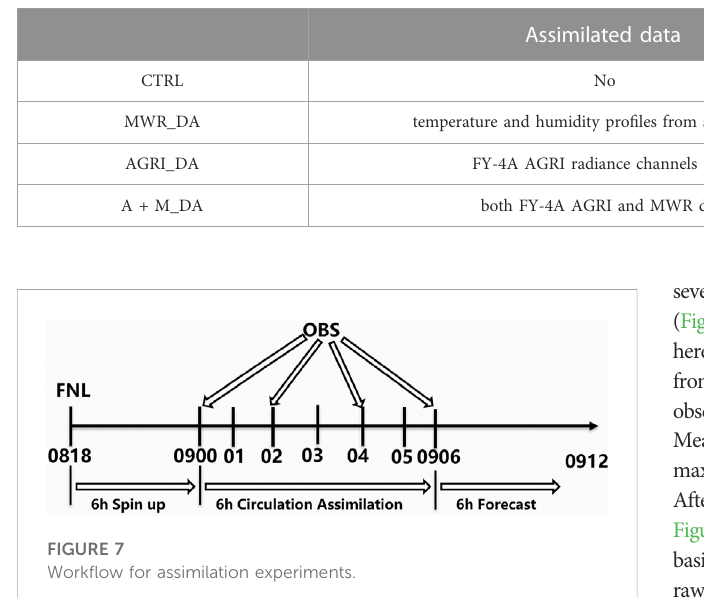
TABLE 2 Assimilation scheme.